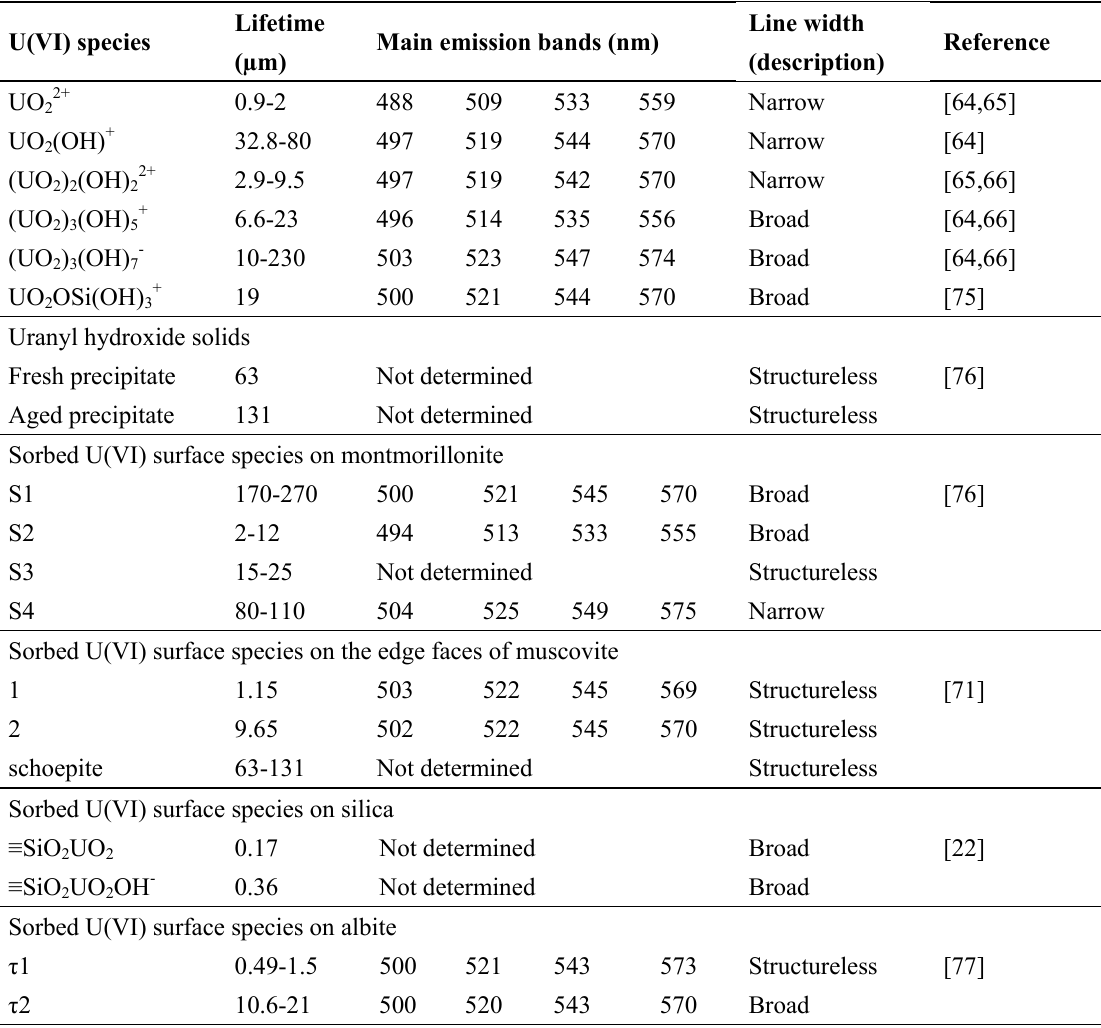
Table 2. Fluorescence data of aqueous, adsorbed, and soil reference